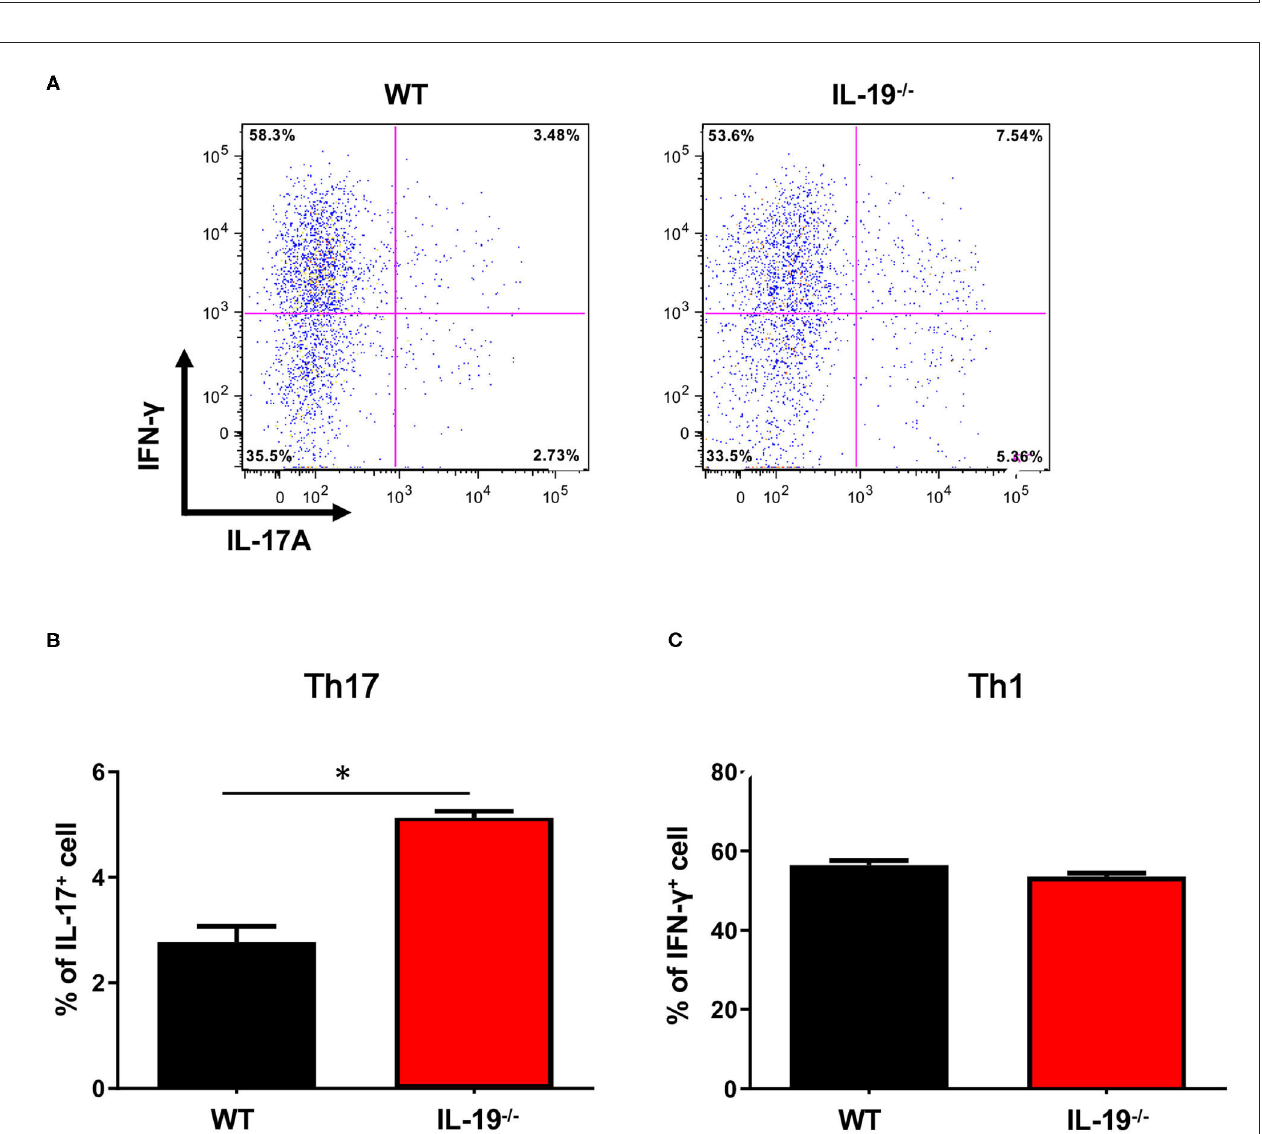
FIGURE 1 | spinal cords at the peak EAE of WT and IL-19 − / − mice. The right panels show enlargements of the boxed areas in the left panels. Scale bars: 500 µ m (left), 100 µ m (right). (C) Quantitative analysis of cell infiltration in L5 lumbar spinal cords at the peak EAE ( n = 5). Statistical significance was analyzed using Student’s t -test. Data represent means ± SEM. ** p < 0.01. (D) Chronological qPCR data for IL-19 mRNA expression level in the spleen of WT EAE mice ( n = 5). (E) Chronological qPCR data for IL-19 mRNA expression level in the lumbar spinal cord of WT EAE mice ( n = 5). Pre, pre-immunization; onset, EAE onset; peak, EAE peak. Statistical significance was analyzed using one-way ANOVA followed by post-hoc Tukey’s test. Data represent means ± SD. ** p < 0.01.